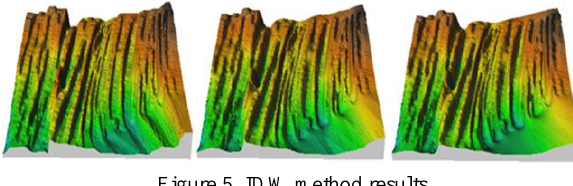
Figure 5. IDW method results